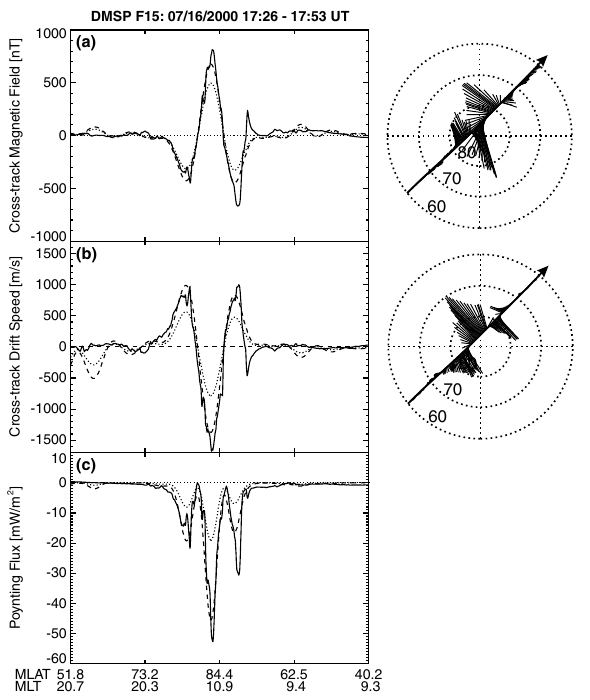
Fig. 7. Comparison of ( a ) the cross-track magnetic perturbation, ( b ) the drift speed, and ( c ) the radial Poynting vector measured by DMSP F13 (solid lines) with calculations using both the unscaled (dotted lines) and scaled (dashed lines) Iridium fit along the DMSP F13 trajectory. The polar plots show the respective vector quantities in AACGM MLT-MLAT